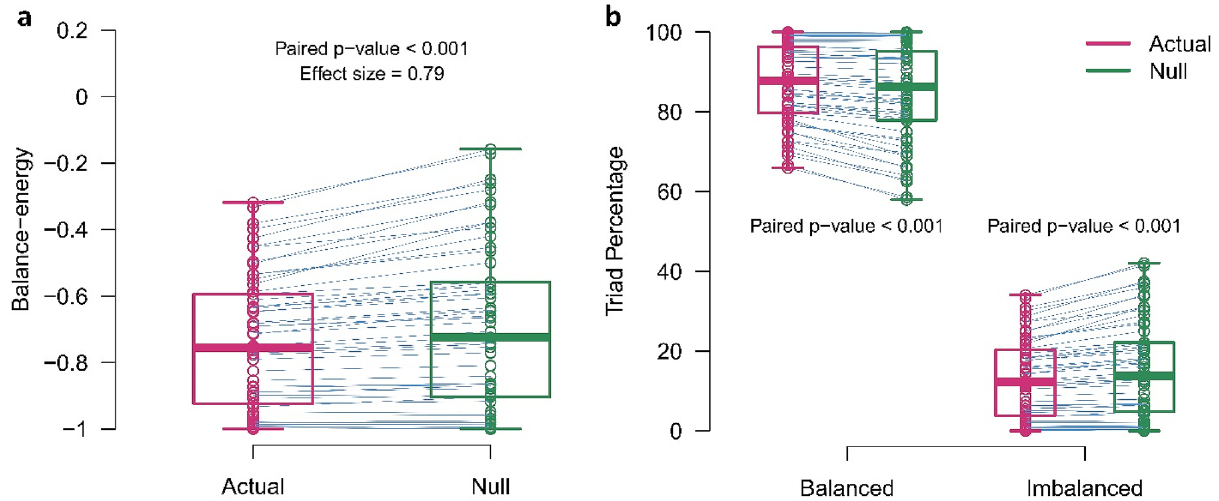
Figure 3. Matched-pairs comparison of balance metrics. (a) Balance-energies. (b) Percentages of triad types. Violet and green colors denote actual-networks and null-networks, respectively. Circles correspond to the signed networks. The boxes indicate median and interquartile ranges. The blue lines also connect the paired points of the actual and ensemble average of null-networks. P-values and effect sizes are related to the Sign